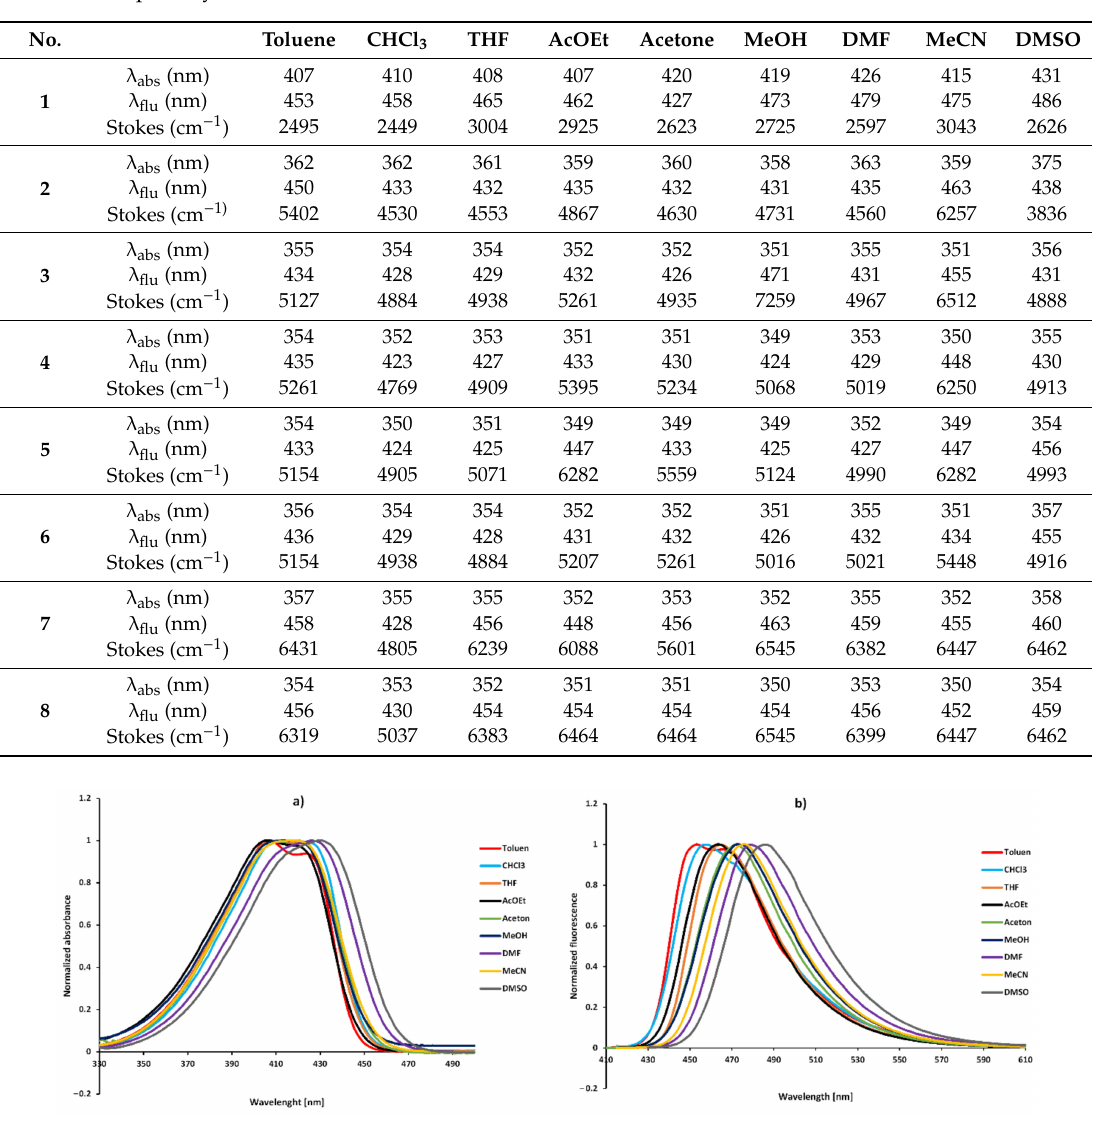
Figure 4. ( a ) Normalized absorption ( a ) and fluorescence ( b ) spectra of 2-(4-dimethylamino)benzoy lbenzoxazole difluoroborane ( 1 ) in solvents of di ff erent